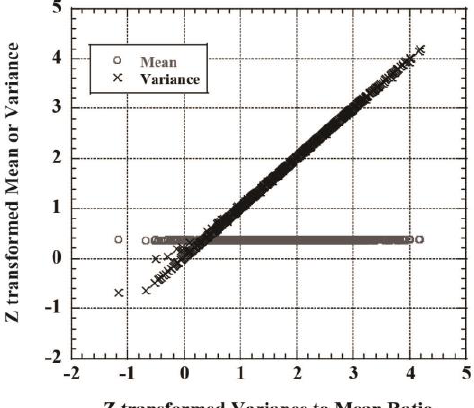
Figure 4. An example of correlation between Mean, Variance and Variance-to-Mean ratio